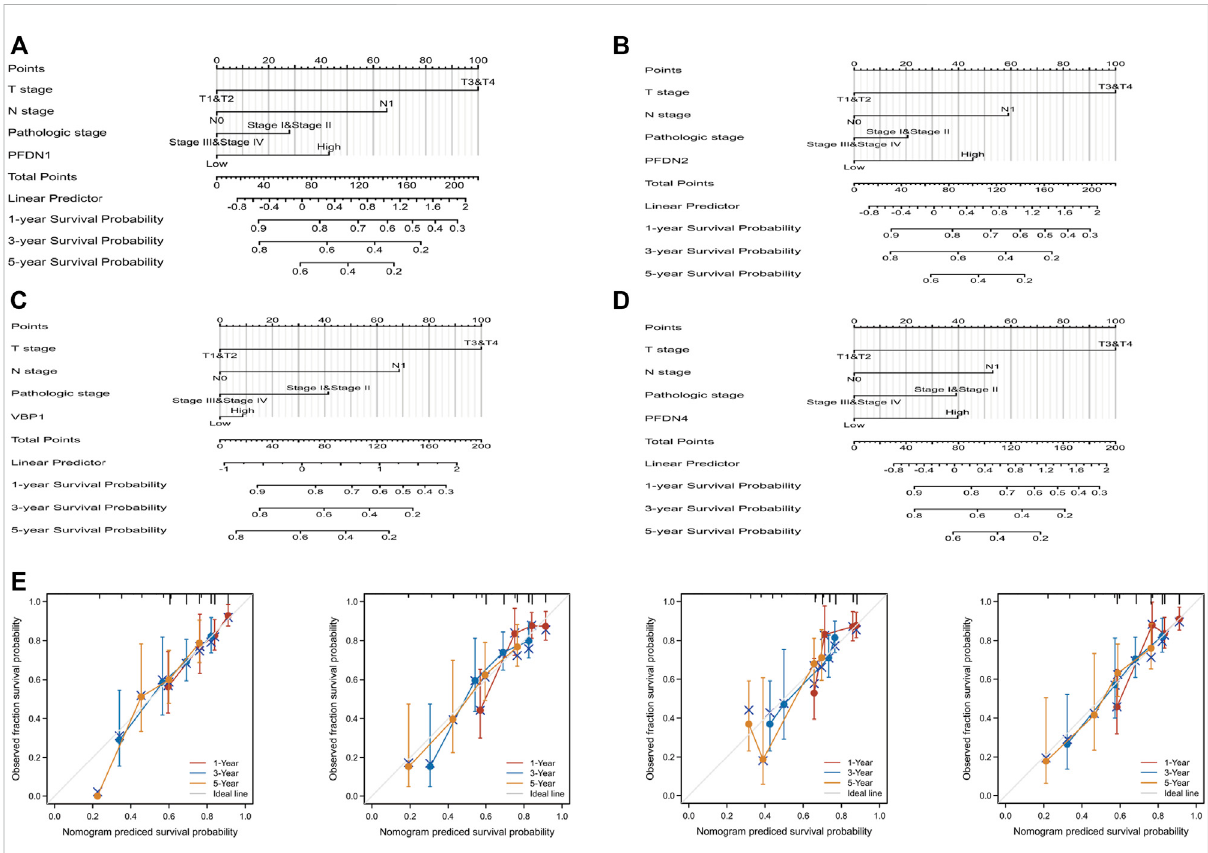
FIGURE 6 Quantitative method to predict HCC patients ’ OS of 1, 3, and 5 years. (A – D) Nomograms for estimating the probability of 1-, 3-, and 5-year OS for HCC patients. (E) Calibration plots of the nomograms of PFDN1-4 for evaluating the probability of OS at 1, 3, and 5 years.